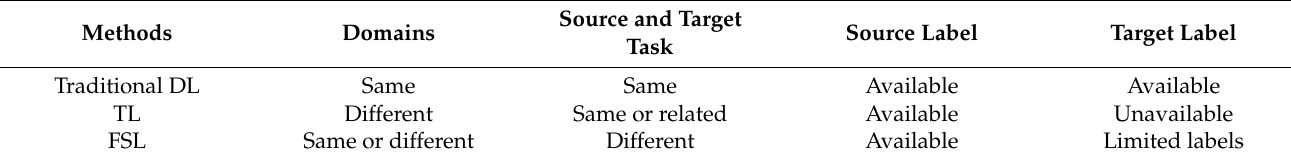
Figure 1. Visualization of ( a ) traditional DL, ( b ) TL, ( c ) FSL. Table 1. The differences between the three methods (i.e., traditional DL, TL, and